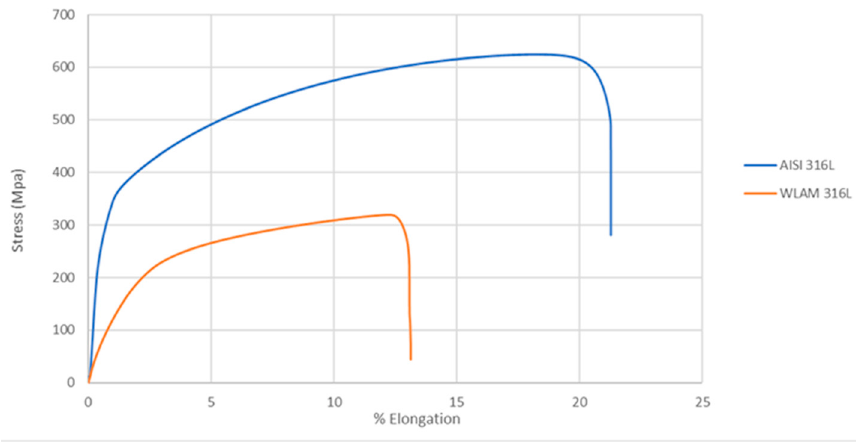
Figure 4. Typical microstructural imperfections in WLAM 316L samples: ( a , b ) porosity in the XY plane and XZ plane, respectively, and ( c , d ) lack of fusion.